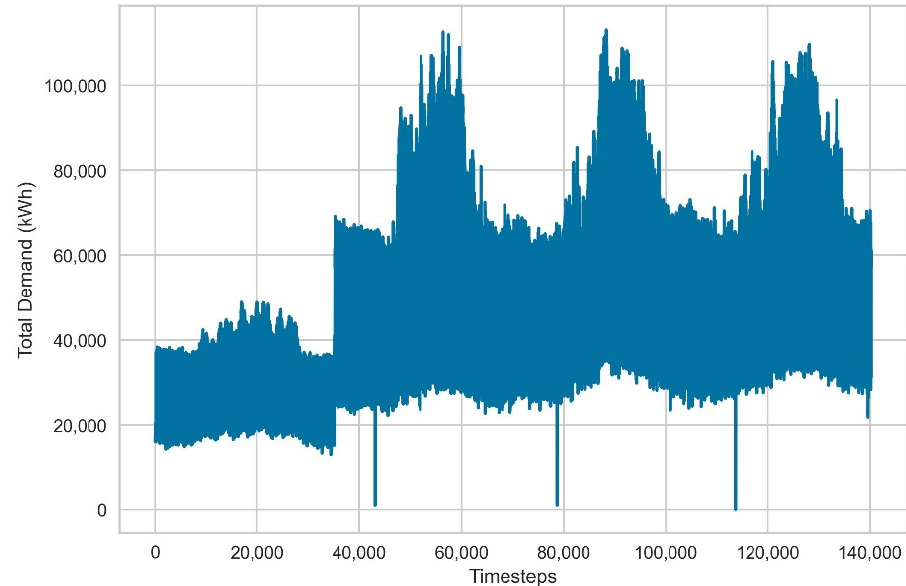
Figure 9. Total electricity demand in kWh for 370 clients.